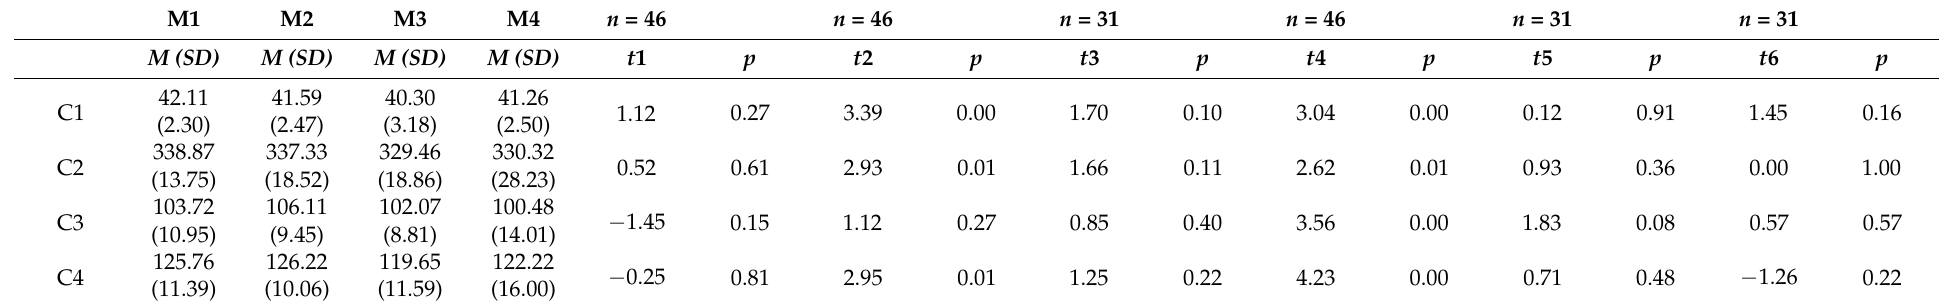
Table 5. Differences in means of the surgical safety competencies in the 4 measurements from the group who trained with the traditional seminars on practical clinical